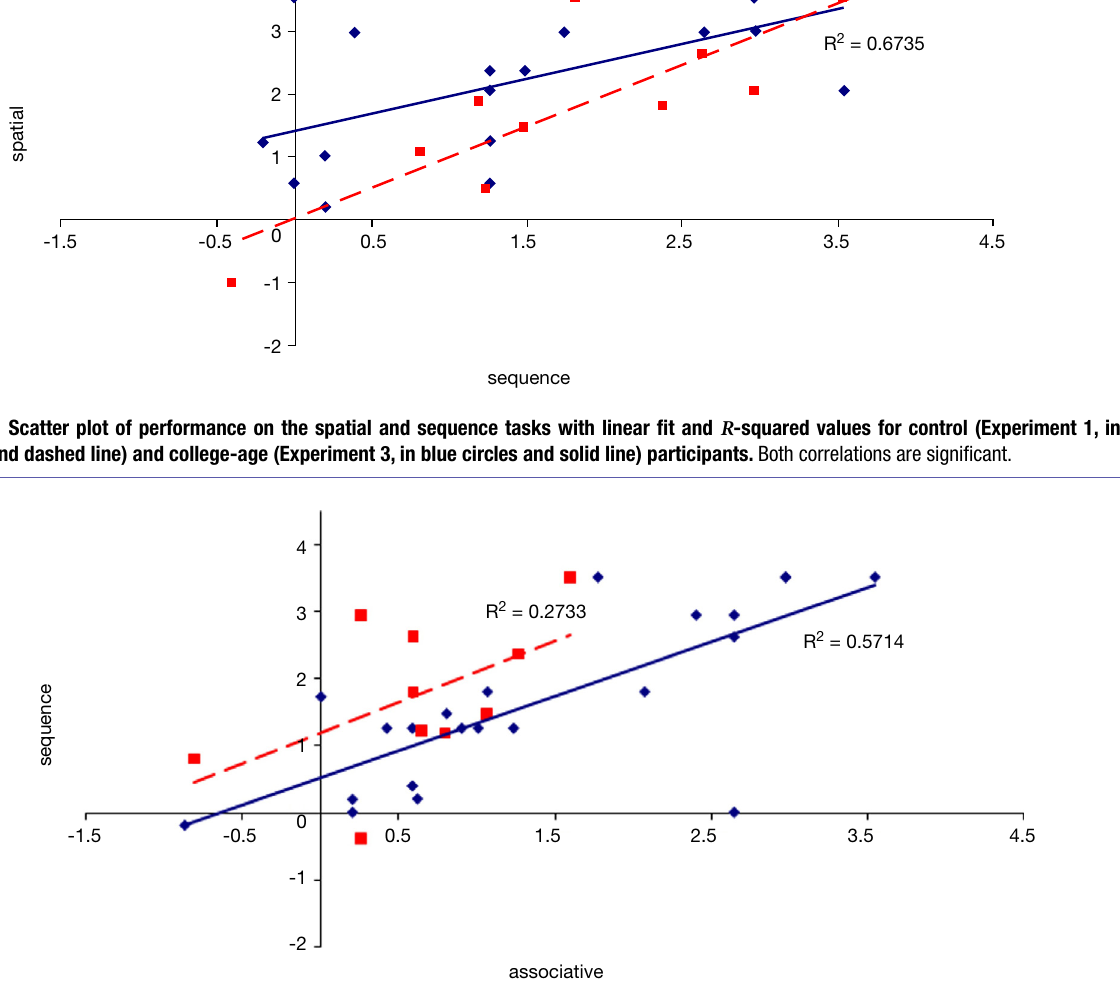
Figure 13 | Scatter plot of performance on the sequence and associative tasks with linear fi t and R -squared values for control (Experiment 1, in red squares and dashed line) and college-age (Experiment 3, in blue circles and solid line) participants. The correlation is signifi cant in college-age participants.